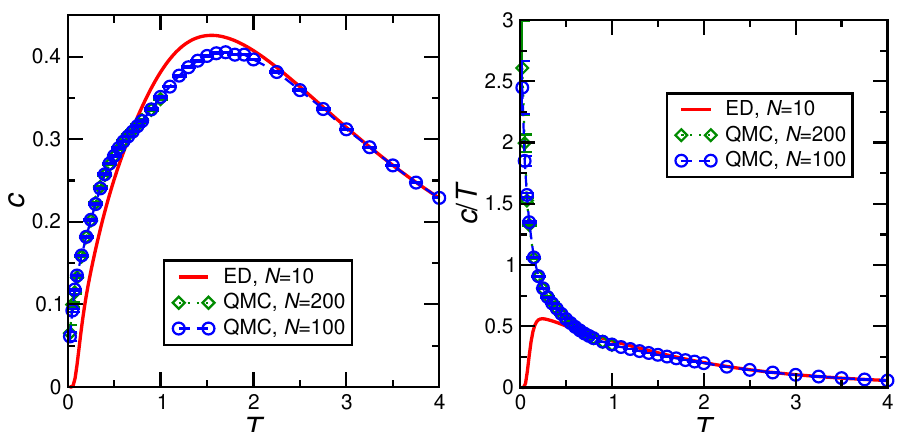
Figure 4. Specific heat per spin c calculated for D = 0, h = 0, J = 1 by exact diagonalization (ED) and Quantum Monte Carlo (QMC). The left panel shows the specific heat itself while the right panel shows the specific heat divided by temperature c / T .